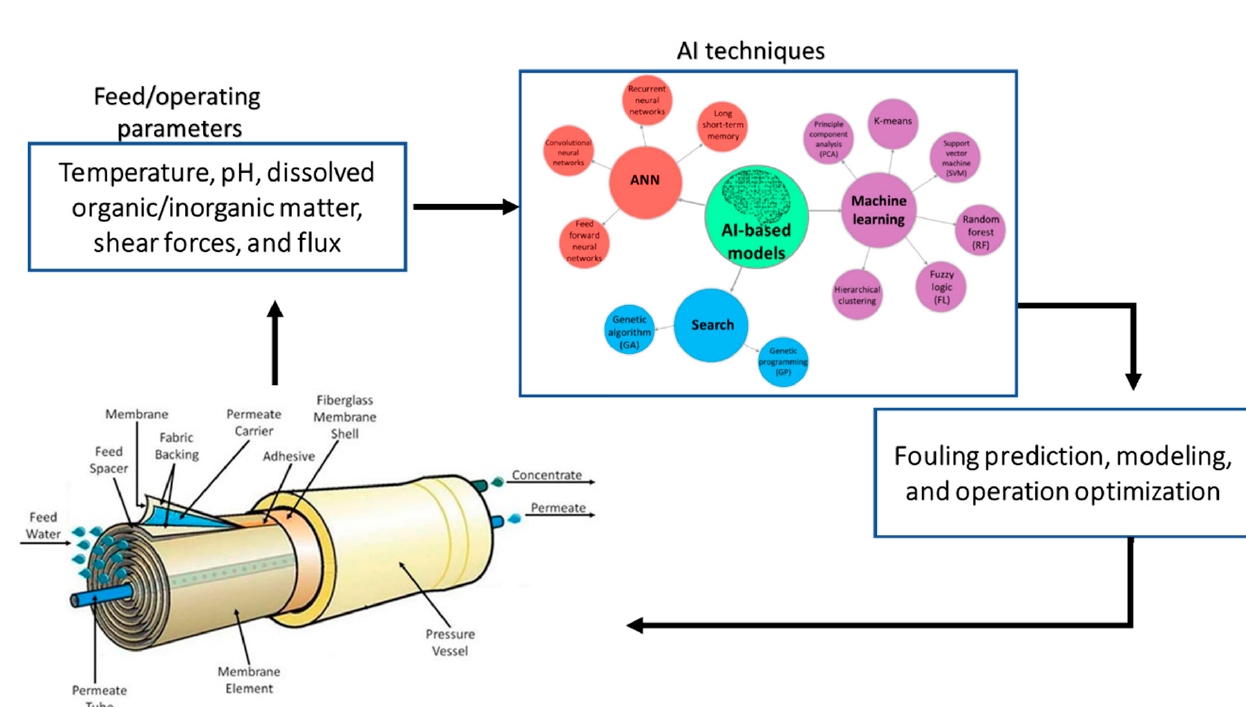
Figure 3. The use of artificial intelligence (AI) in membrane biofouling prediction.